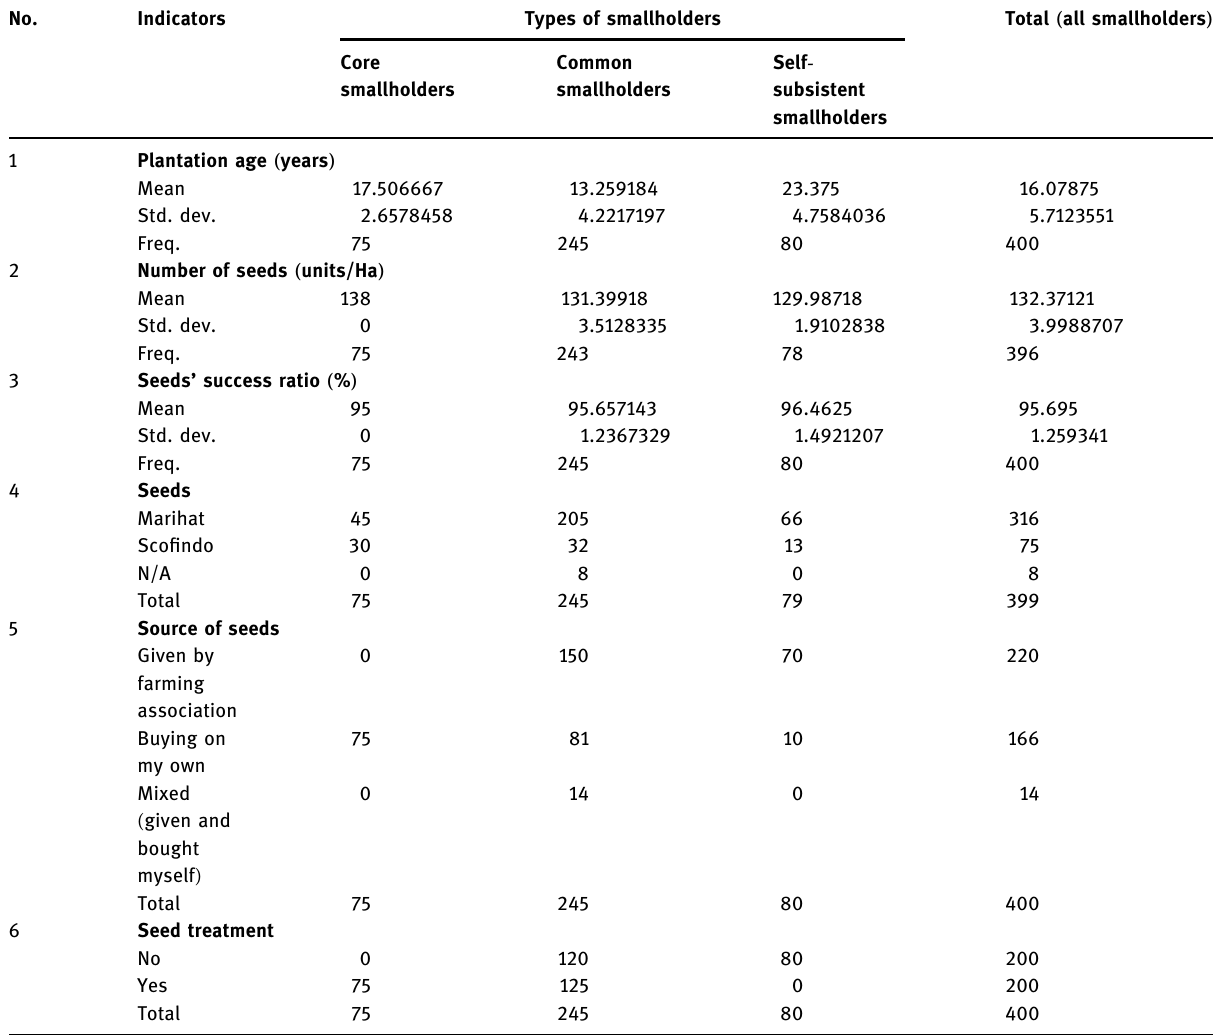
Table 2: Summary statistics of variables related to seeds and planting. Source: survey data, calculated by the author